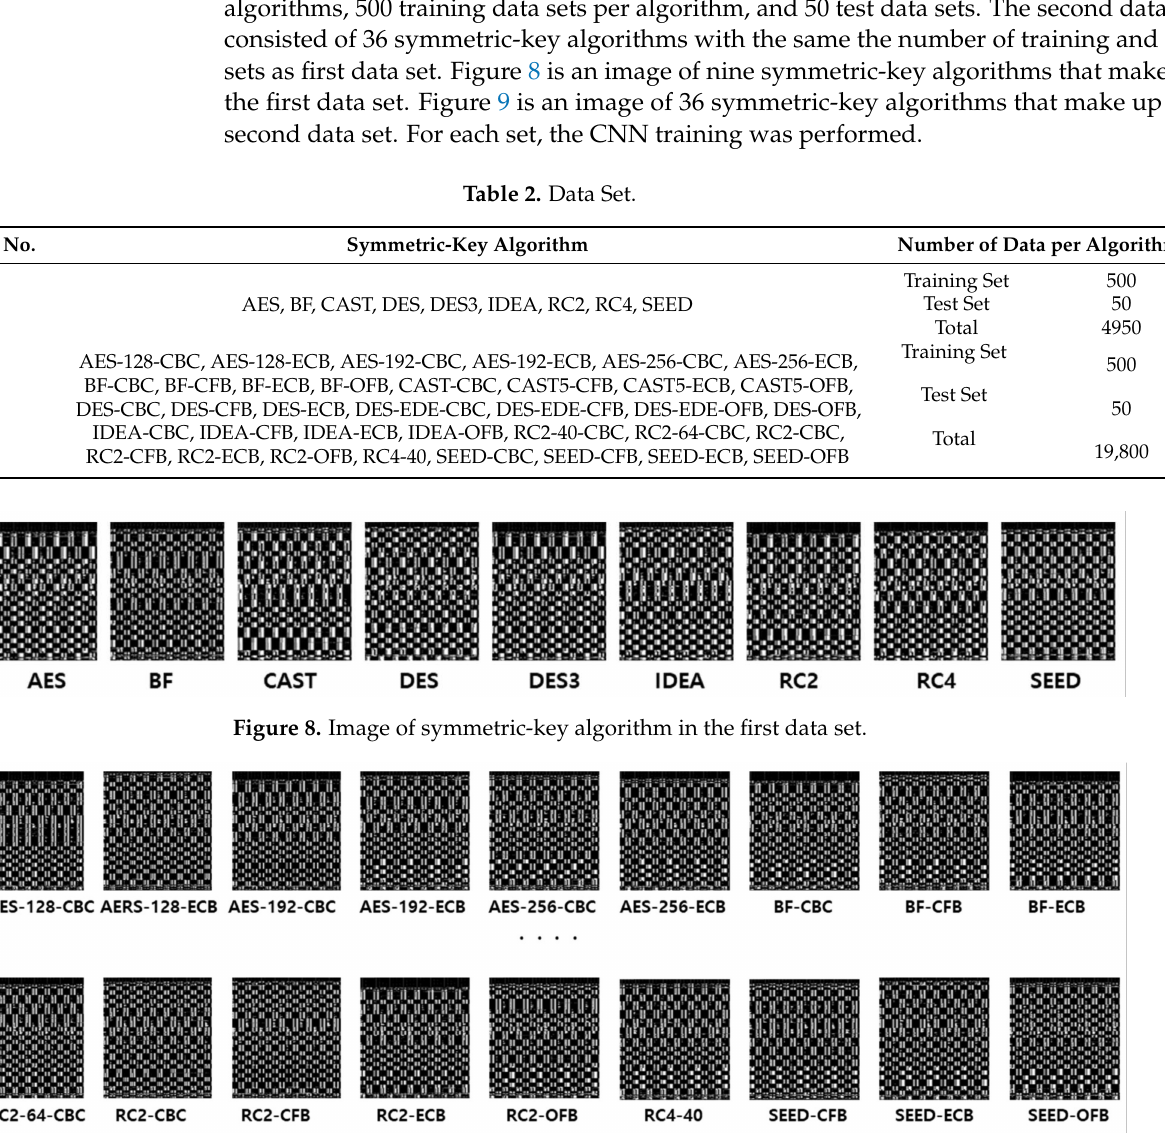
Figure 9. Image of symmetric-key algorithm in the second data